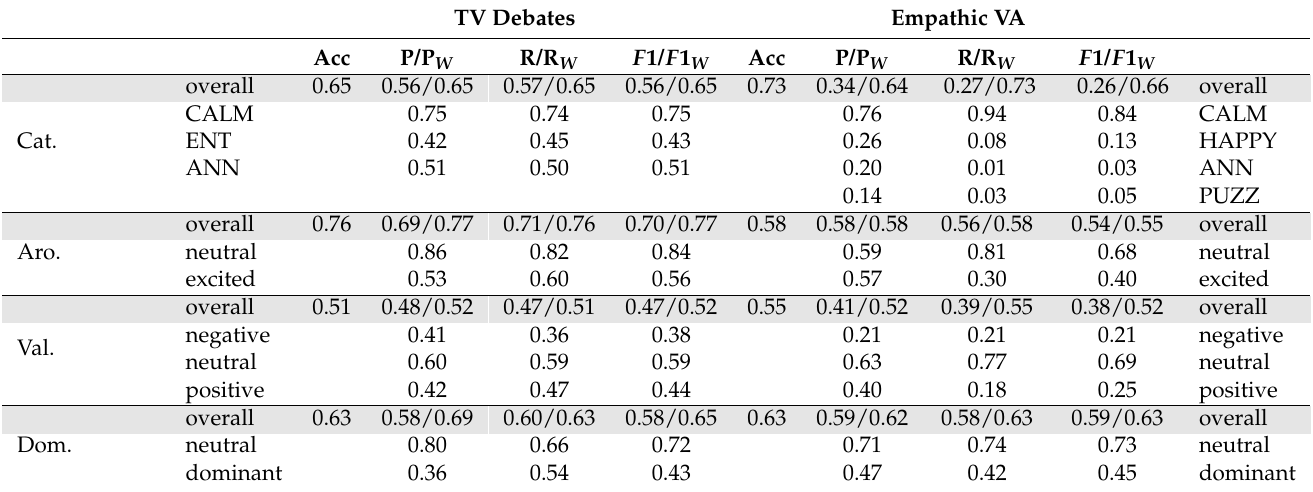
Table 8. Classification results on the spectrogram input for each of the problems (categorical and each dimension of the VAD) and corpus (TV Debates and Empathic VA). Each problem has a row per category with the precision, recall, and F 1-score metrics and a row of means (Overall) that shows the macro and weighted average measures of the metrics for all categories.